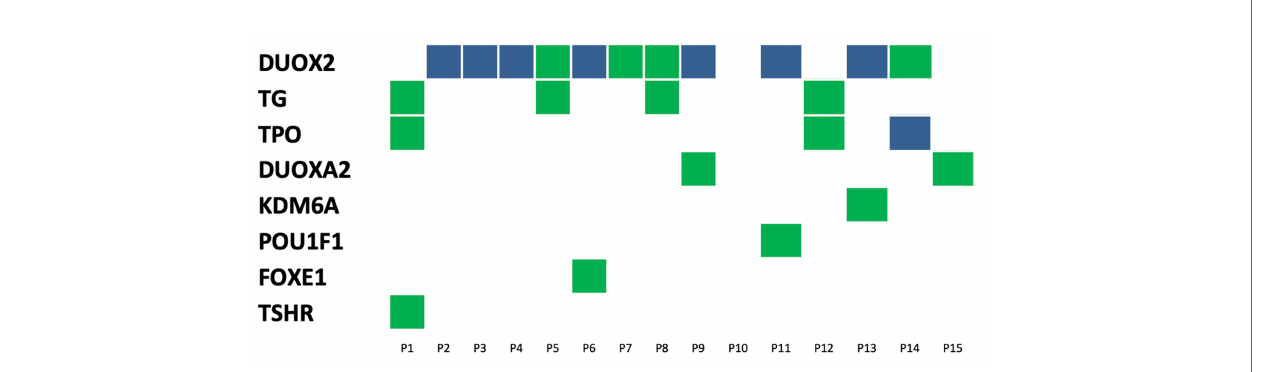
FIGURE 1 | Distribution of variants in15 congenital hypothyroidism. The left side was 8 detected genes with variants, and the number on top of each box is the patient ID. Each column represents a patient and each row represents a gene. Blue blocks represent biallelic variants and green blocks represent monoallelic variants. Such as patient 9 carries variants on two genes: biallelic variants in the DUOX2 gene and monoallelic variant in DUOXA2.